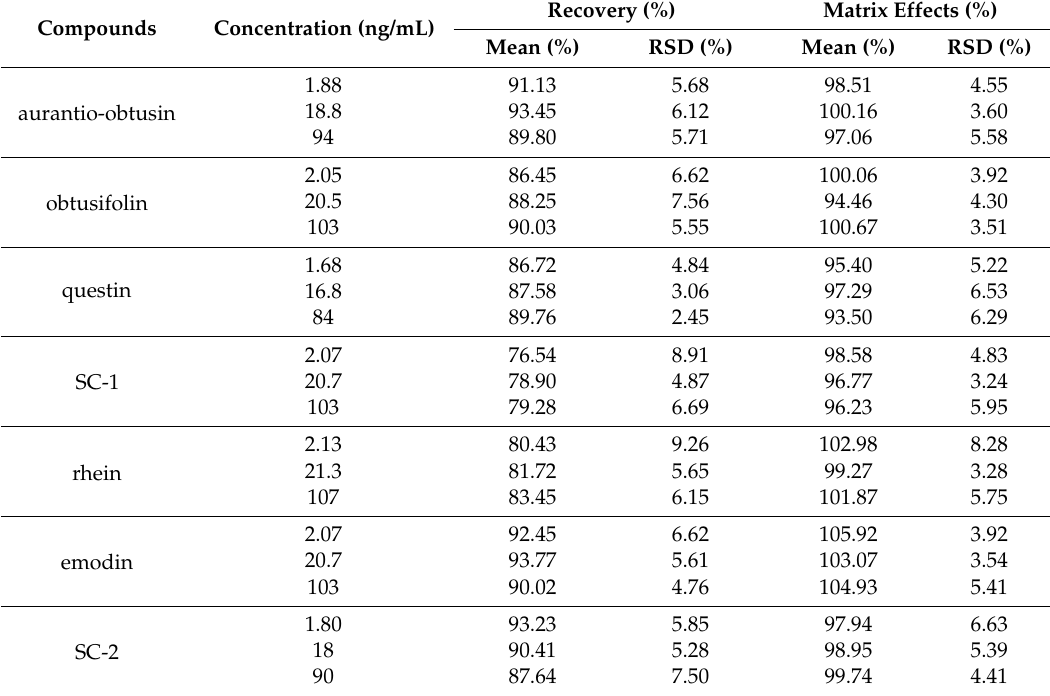
Table 3. Recovery and matrix effects for the seven analytes in rat plasma ( n = 6).